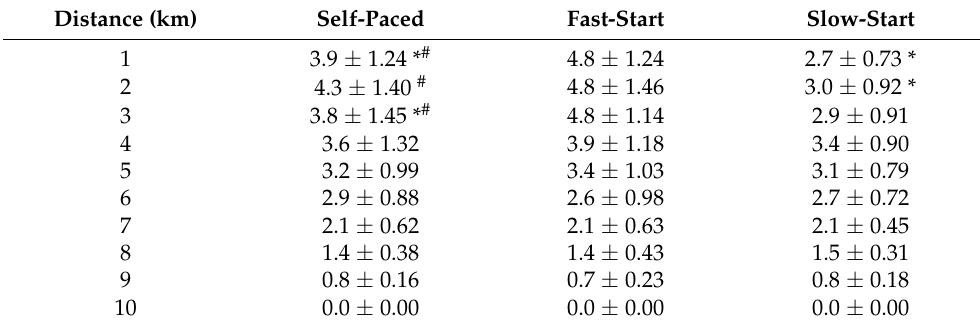
Table 7. Means ± standard deviations of the Hazard Score during self-paced, fast-start, and slow-start time trials.